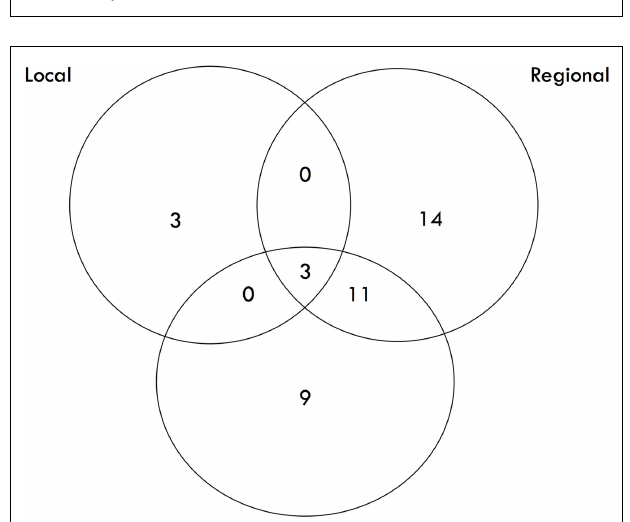
FIGURE 2 | Local Control .